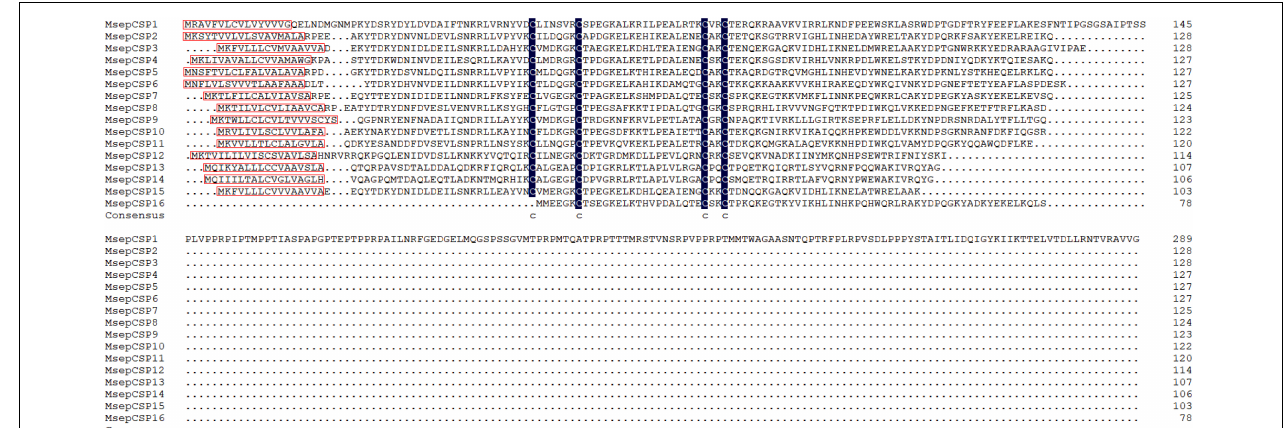
FIGURE 4 | Multiple alignment of amino acid sequences of CSPs from M. separata . In the sequence alignments, the C-terminus of CSP15 and N-terminus of CSP16 are truncated. Four conserved residues are highlighted, and signal peptides are boxed in red.